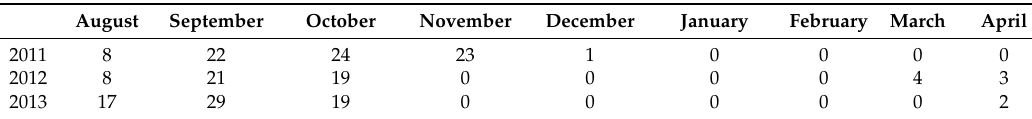
Figure 2. ( a ) Count and ( b – f ) distribution of the ratios under non-depleted and depleted ozone hole period (OHP) conditions, and in non-ozone hole months, and of the ratios in relation to the B199 ozone column for ( b ) the D099, ( c ) the OMI(TOMS), ( d ) the OMI(DOAS), ( e ) the GOME2, and ( f ) the SCIAMACHY for the period 2011–2013 at the Marambio Base. Table 2. Number of days with at least one TOC record below 220 DU based on the B199 Brewer spectrophotometer observations at the Marambio Base for the period